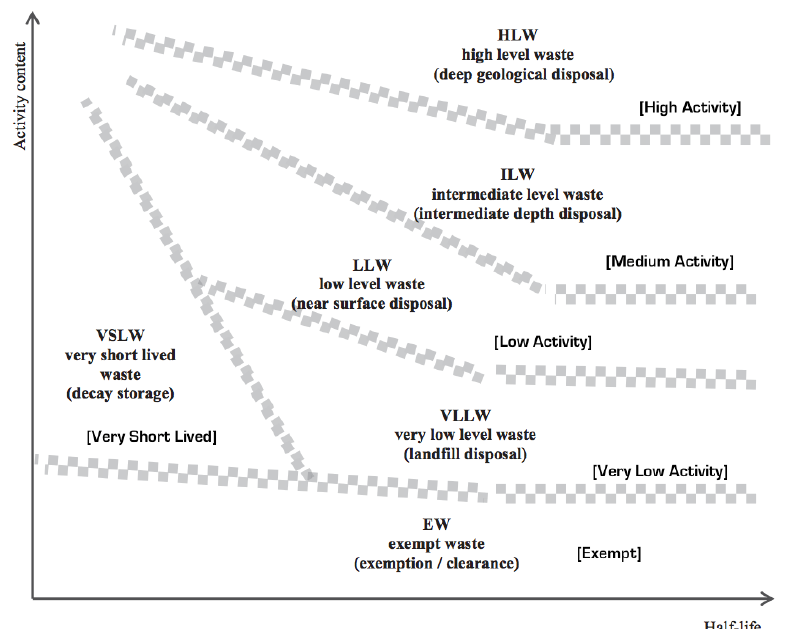
Figure 4. Radioactive waste classification as IAEA General Safety Guide 1. In square brackets the